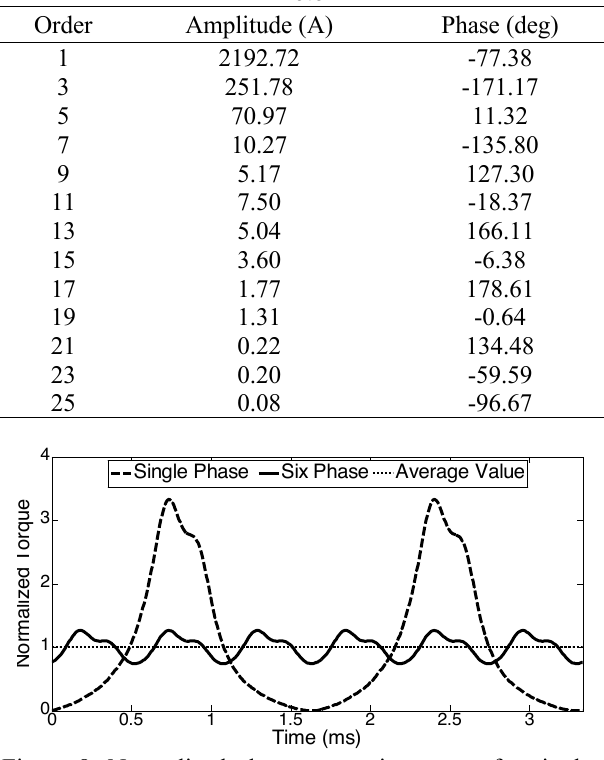
Figure 8: Normalized electromagnetic torques for single- phase and 6-phase motors. Table 8: Harmonics of Electromagnetic Torques for